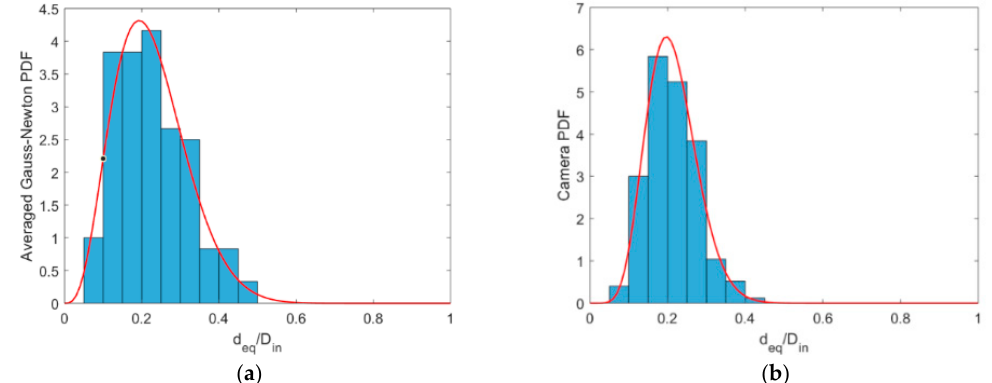
Figure 18. Histograms and Beta distribution PDFs for the ERT ( a ) and Camera ( b ) values for experimental point 11. Only the 120 frames of the last 10 s of ERT measurement are considered during the plot. Both histograms are plotted in 20 intervals uniformly spaced between 0 and 1.